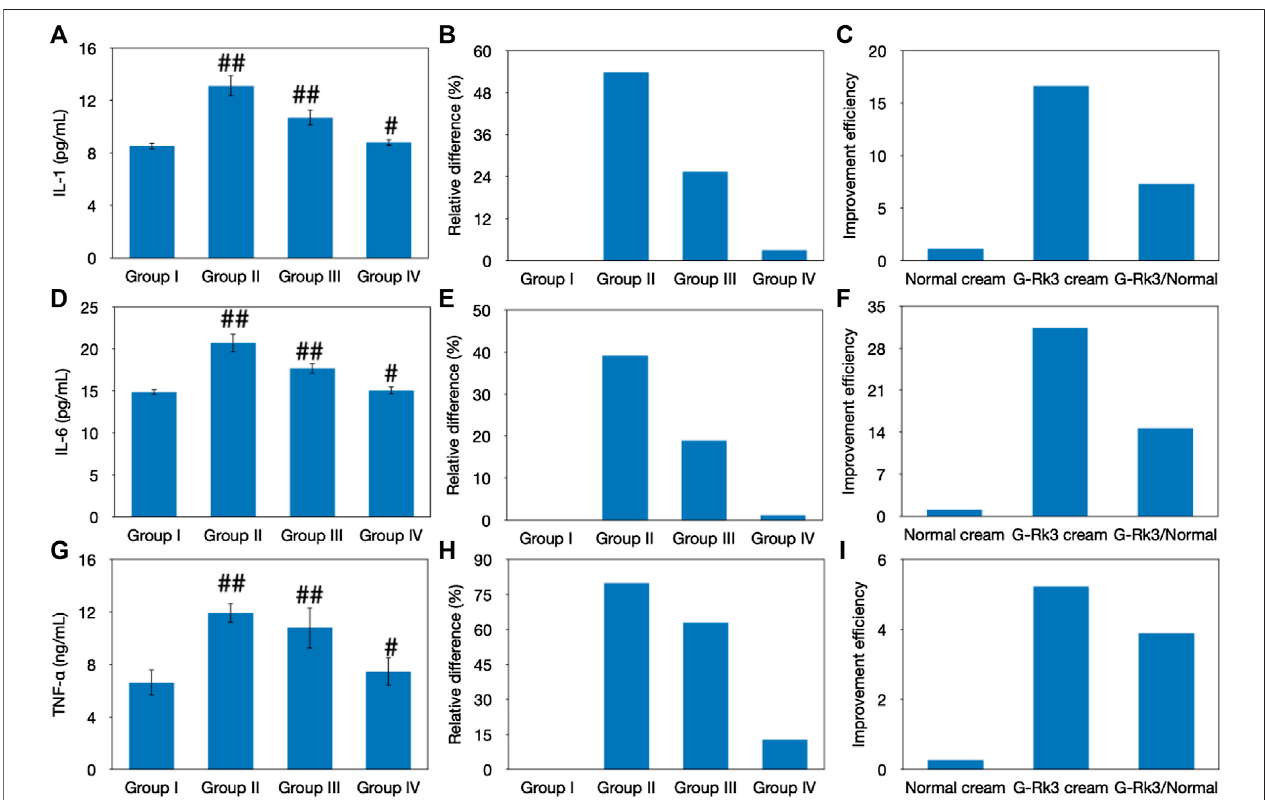
FIGURE 9 | Evaluation of skin in fl ammation. Changes in the levels of IL-1 (A – C) , IL-6 (D – F) , and TNF- α (G – I) . The absolute value (A, D, G) . ##Very signi fi cantly differentfromgroupI, p < 0.01.#Signi fi cantlydifferentfromgroupI, p < 0.05.Relativedifferencesinfourgroups (B,E,H) .Improvementef fi cienciesofnormalandG-Rk3 creams (C, F, I) .